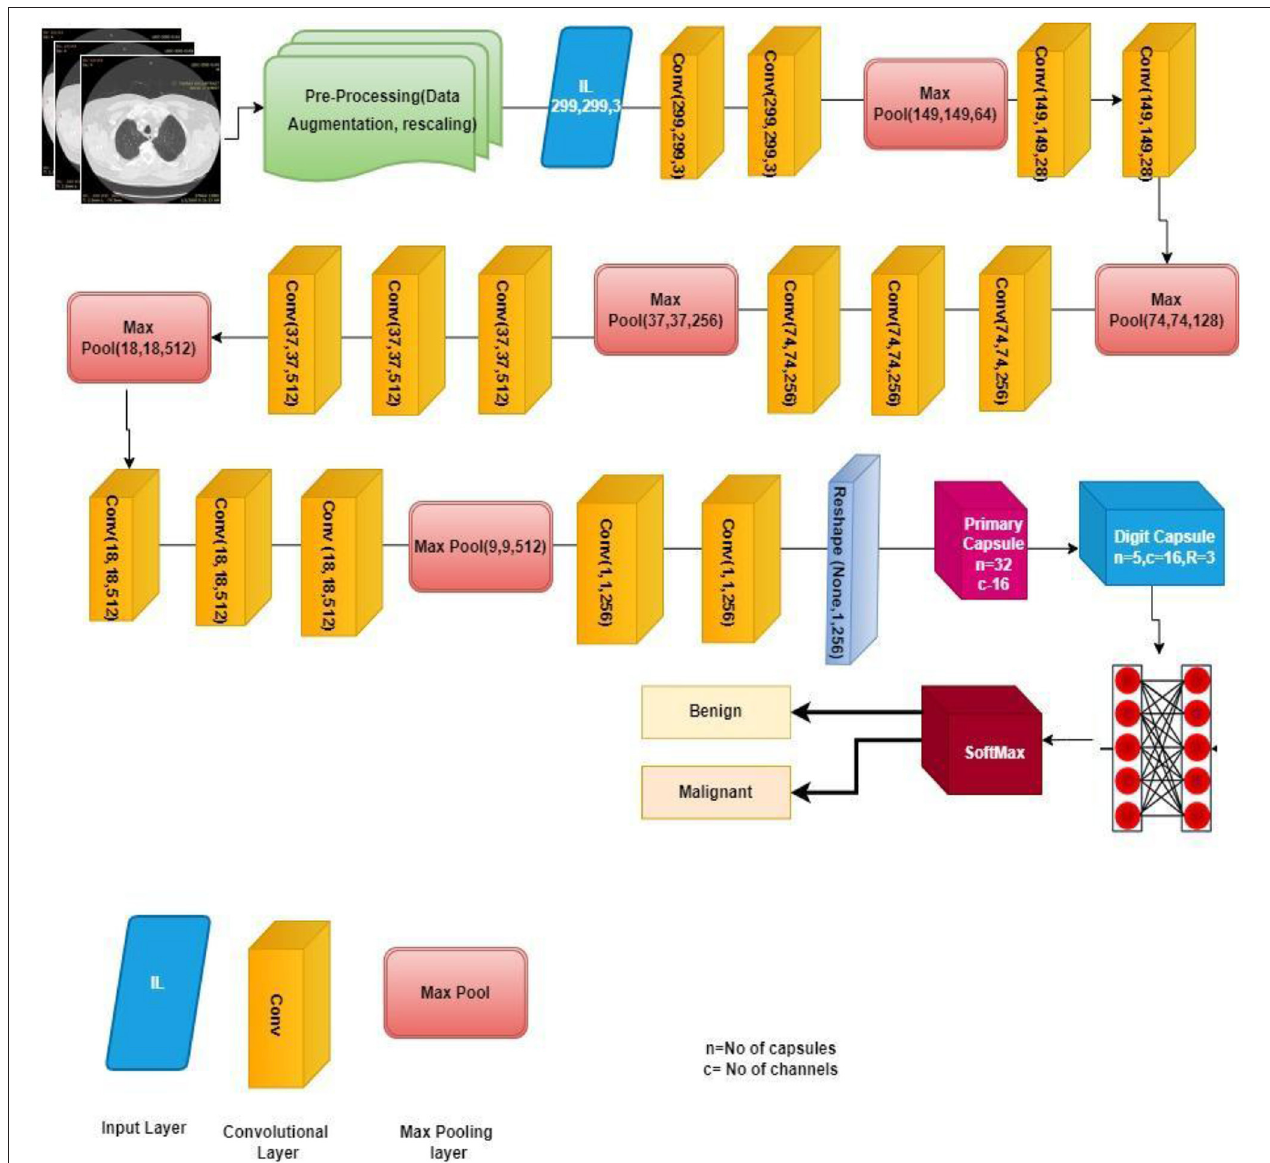
FIGURE 6 | Proposed VCNet for the classification of lung